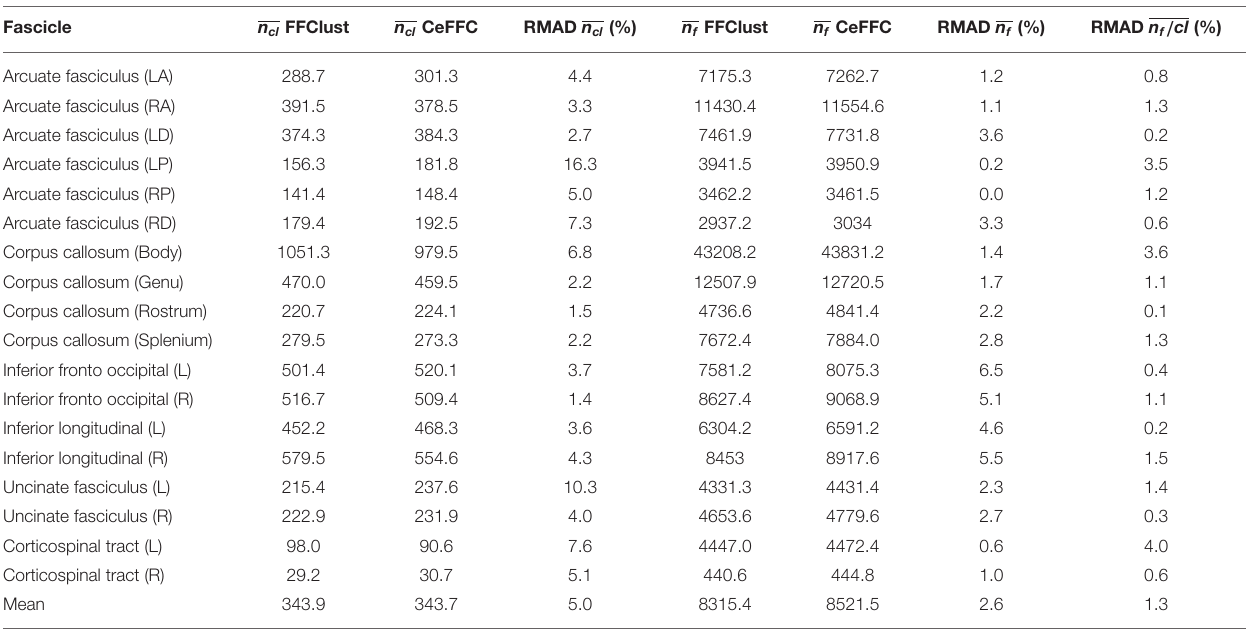
TABLE 2 | Bundle segmentation